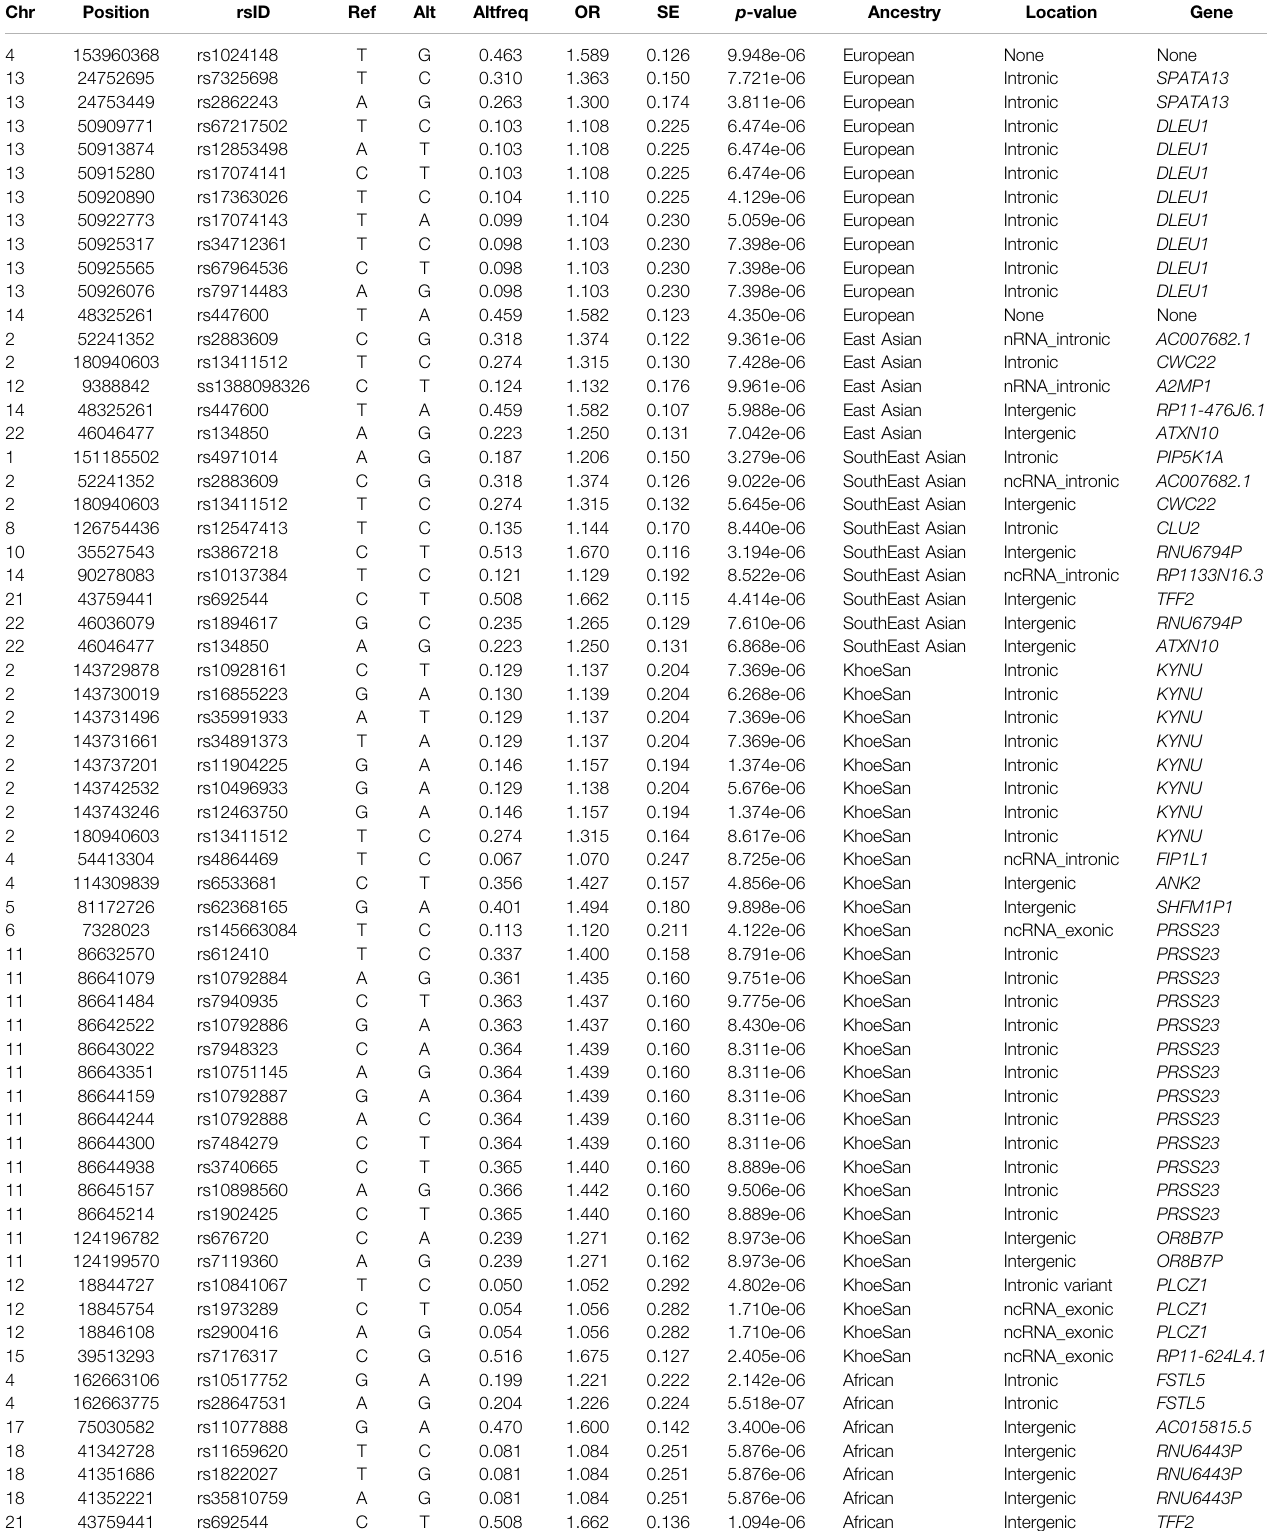
TABLE 2 | Summary statistics of the top results ( p -value < 1 × 10 − 5 ) whilst utilising the Additive allelic model whilst adjusting for local ancestry. Chr